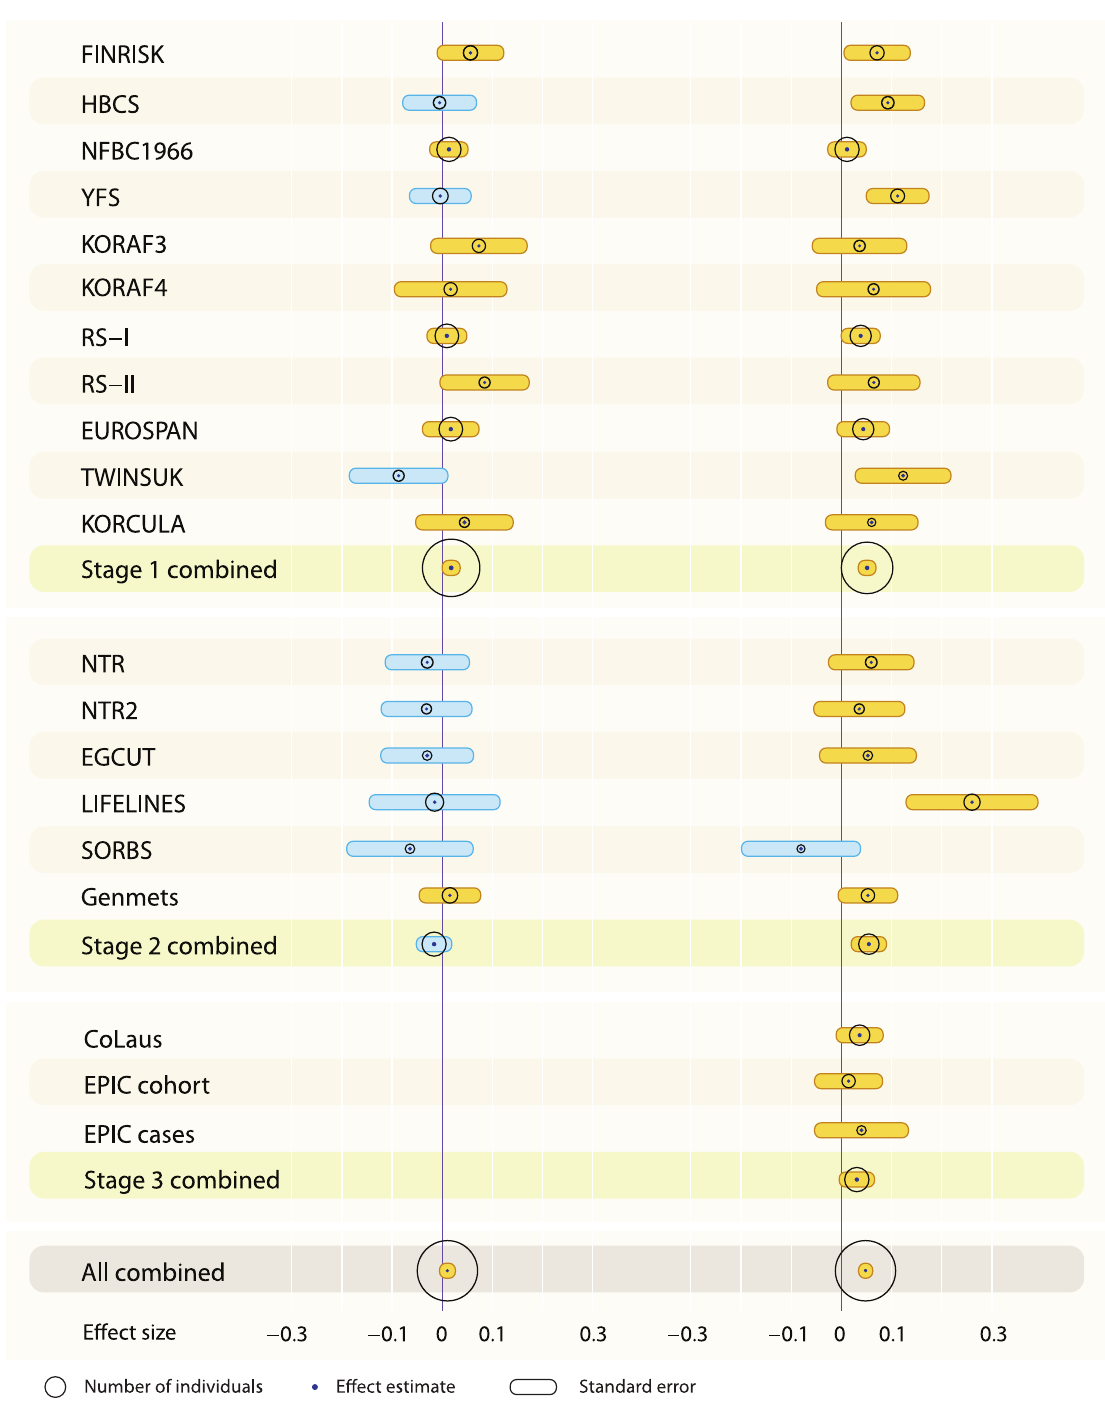
Figure 1. Forest plot of main and WHR interaction effect sizes of rs6448771 on TC across the study cohorts. The circles in the plot are positioned at the effect estimates, betas, and the size corresponds to the number of individuals. The whiskers correspond to the standard errors of betas.